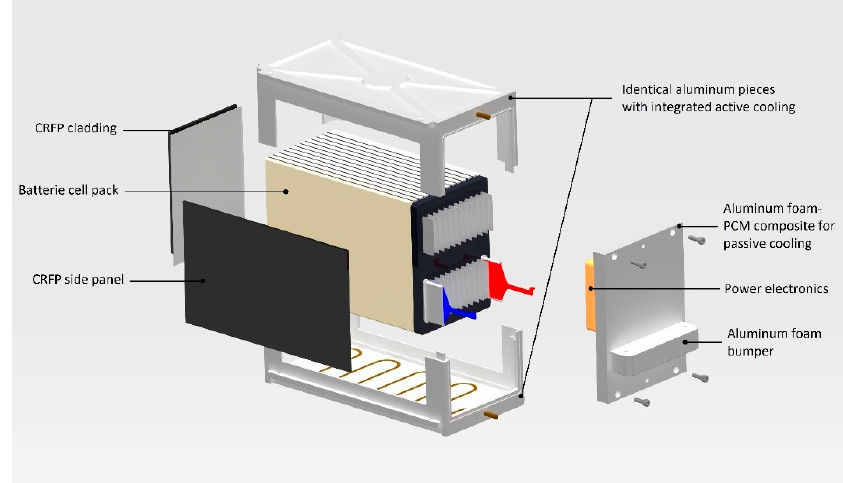
Figure 1. Exploded CAD view of the developed battery module and its components.